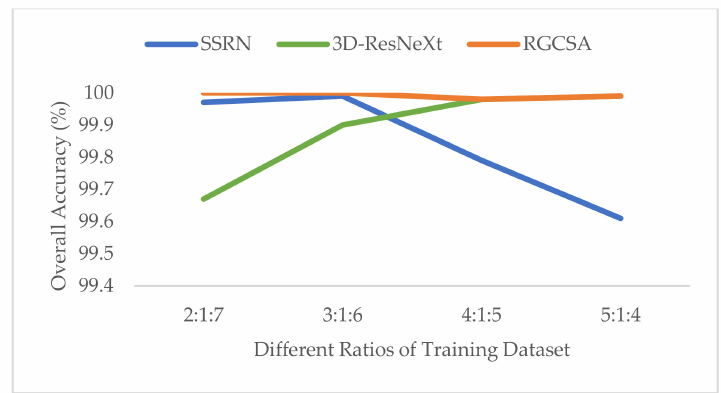
Figure 16. OAs of the SSRN, 3-D-ResNeXt, and RGCSA with di ff erent ratios of training samples for the KSC dataset.